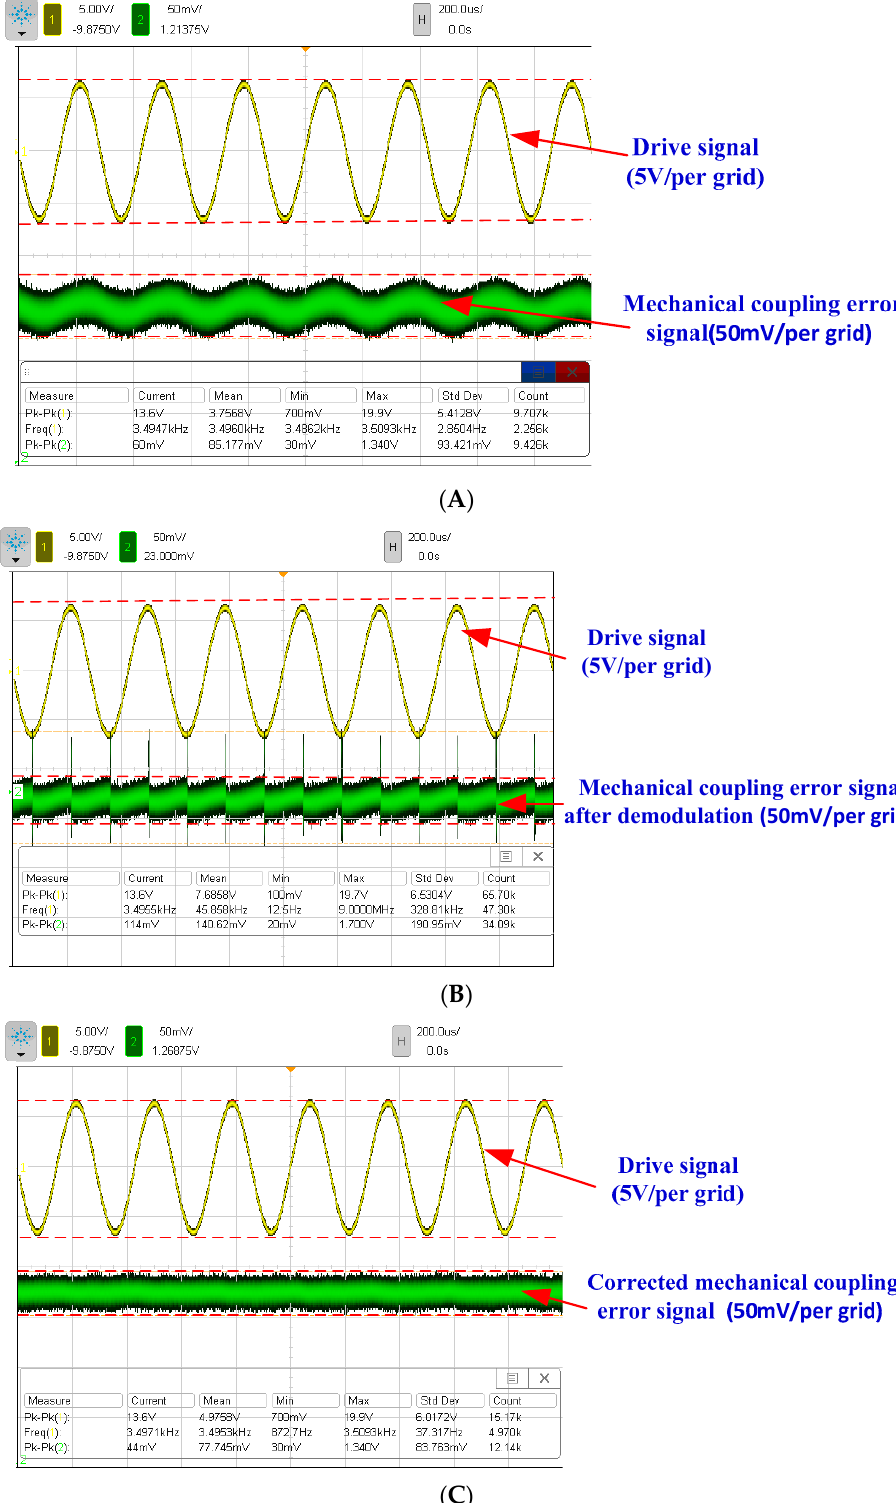
Figure 15. Mechanical coupling error measurement and suppression. ( A ) The mechanical coupling error signal waveform of the pre-amplifier in open loop sense (yellow signal is the reference drive signal in channel 1); ( B ) The mechanical coupling error signal waveform of the open loop sense after demodulation; ( C ) The mechanical coupling error signal waveform of the pre-amplifier after quadrature correction and feedback control.